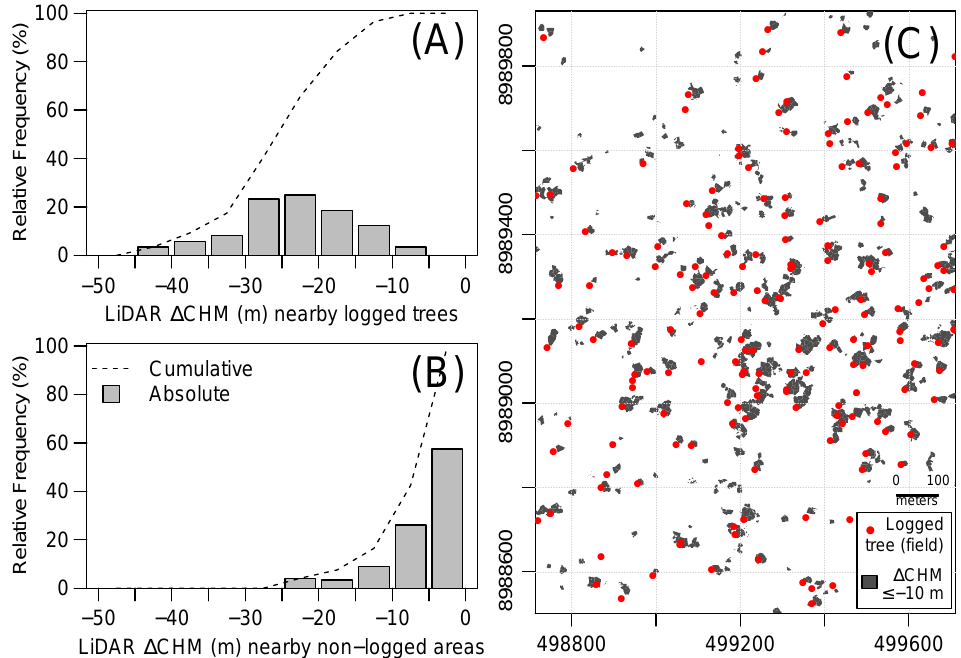
Figure 3. Tree loss detection using LiDAR ∆ CHM in the Jamari National Forest over the UPA-06. Relative frequency of the most negative ∆ CHM within a 30 m radius of ( A ) logged trees and ( B ) non-logged areas. ( C ) LiDAR-based tree loss map considering ∆ CHM ≤ − 10 m (UTM, datum